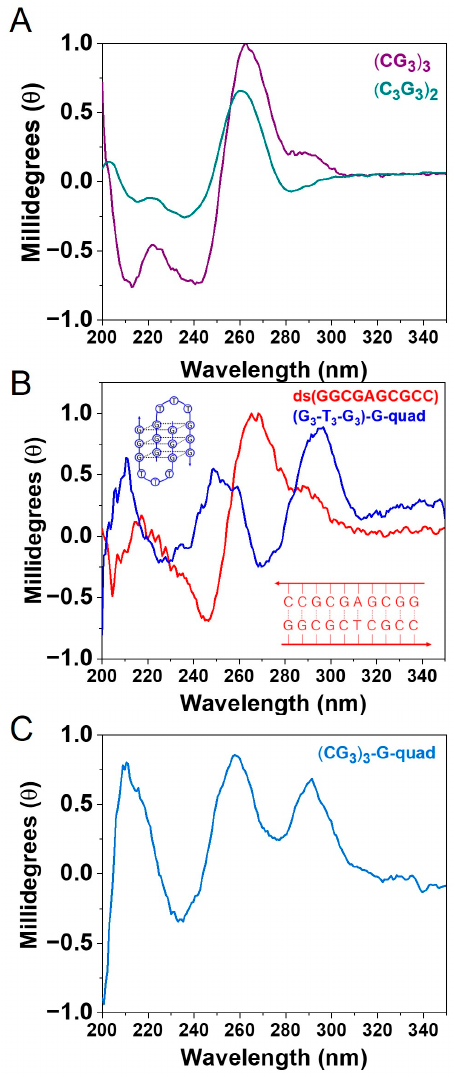
Figure 3. Circular dichroism spectra measured in 100 mM PBS for ( A ) (CG 3 ) 3 (purple) and (C 3 G 3 ) 2 (dark cyan). ( B ) CD spectrum for ds(GGCGAGCGCC), red line, with a B-form helical structure, which is distinguished by a positive band between 260 and 280 nm and a negative band near 245 nm. The blue line is the CD spectrum for the antiparallel configuration of (G 3 -T 3 -G 3 )-G-quad with a positive band at 290 nm; inset: schematic representations of ds(GGCGAGCGCC) (red) and (G 3 -T 3 - G 3 )-G-quad (blue). ( C ) The light blue line depicts (CG 3 ) 2 -G-quad hybridized in solution without the complementary strand, resulting in a G-quad structure with a positive peak at 290 nm.